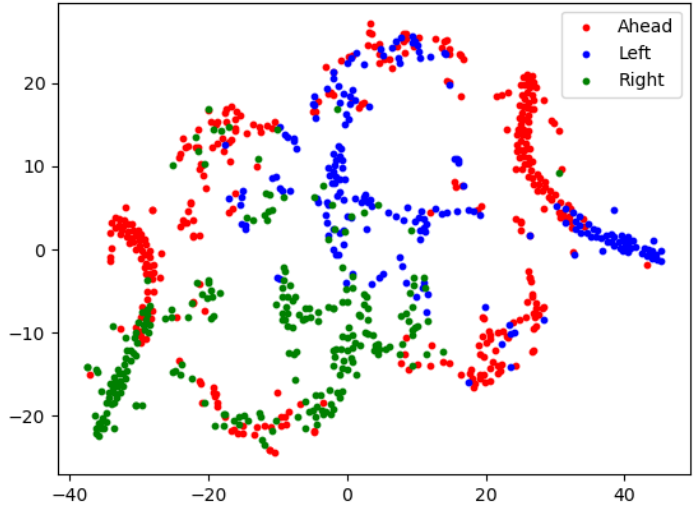
Figure 7. 2D plot of input data with marked labels using t-SNE.